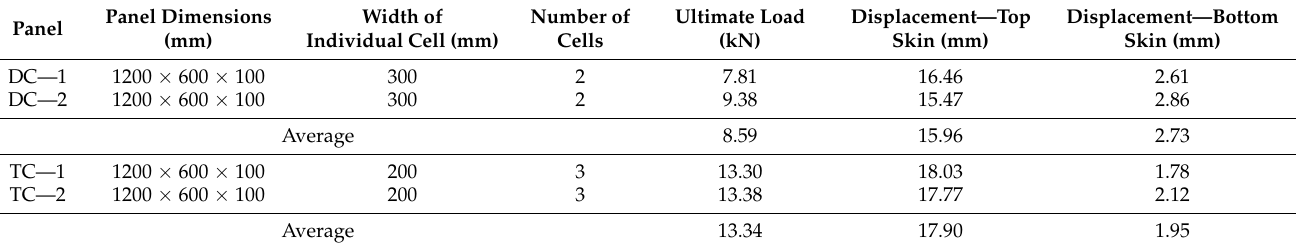
Table 3. Results of multi-cell panel